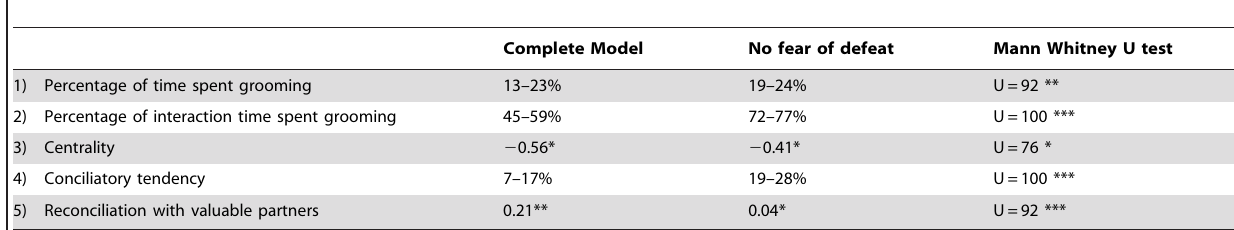
Table 7. Comparison between different variables of the complete model and the model without fear of defeat at high intensity of aggression (Mann Whitney U test,